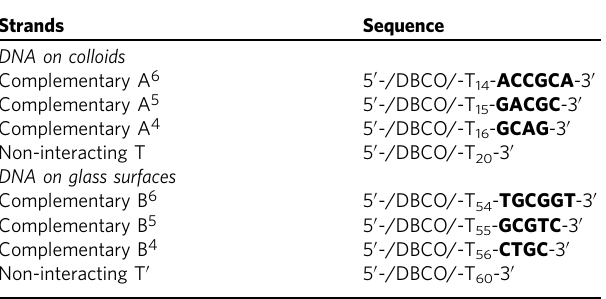
DNA sequences in bold font indicate complementary base